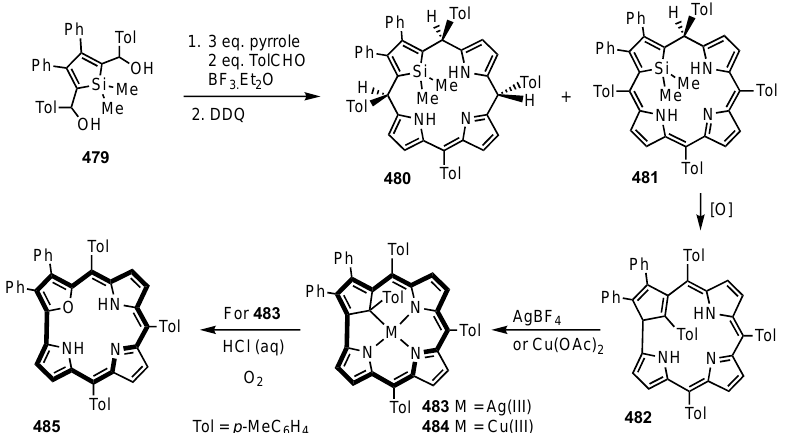
482483 M = A g ( III ) 3 eq . p y rr o l e 484 M = C u ( III ) 2 eq . T o l CH O Scheme 73. Silver(III) and copper(III) complexes of carbacorrole. T o l O H Azulicorrole 465 was obtained in low yield by condensing azulene, pyrrole and 4- trifluoromethylbenzaldehyde in 10% TFA-CH 2 Cl 2 , followed by oxidation with DDQ (Scheme 74) [293]. Azulicorrole reacted with copper(II) acetate and gold(III) acetate to give metalated derivatives 486a,b in 89% and 32% yield, respectively [293]. The X-ray structure for 464 showed that the azulene ring was tilted ca. 40° relative to the remaining macrocy- clic plane, but as might be expected copper(III) complex 486a was relatively planar. Bilane 487 with two terminal indole units was cyclized with 10 equivalents of copper(II) acetate to give copper(III) complex 488 together with 2.2 ′ -biindole-linked macrocycle 489 in 12% and 18% yield, respectively [305]. The proton NMR spectrum of 488 indicates that there is an 18π electron delocalization pathway in the complex. Attempts to demetalate 488 with zinc dust in TFA-acetonitrile-CH 2 Cl 2 to form the parent porphyrinoid were unsuccessful and resulted in the structure being converted back into bilane 487 .